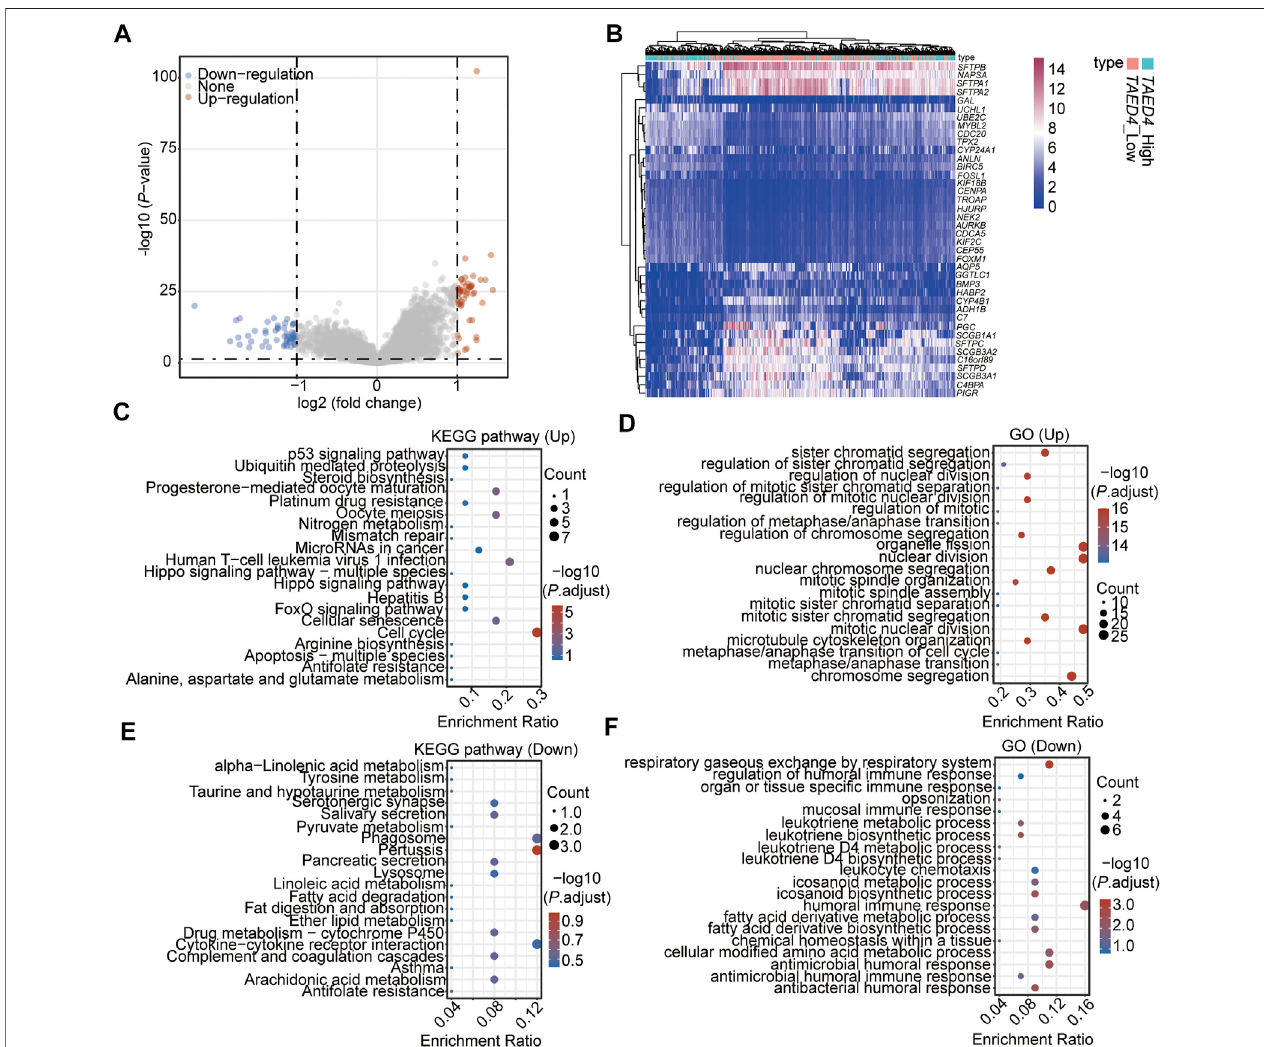
FIGURE2| Identi fi cationofDEGsassociatedwiththeTEAD4differentialexpression. (A) VolcanoplotshowingtheDEGsin TEAD4- highvs. TEAD4- lowgroups. (B) Heatmap showing the top 20 up- and top 20 downregulated genes in TEAD4- high vs. TEAD4- low groups. (C) KEGG analysis of upregulated genes in the TEAD4- high group. (D) Enriched GO terms of upregulated genes in the TEAD4- high group. (E) KEGG analysis of downregulated genes in the TEAD4- high group. (F) Enriched GO terms of downregulated genes in the TEAD4- high group.